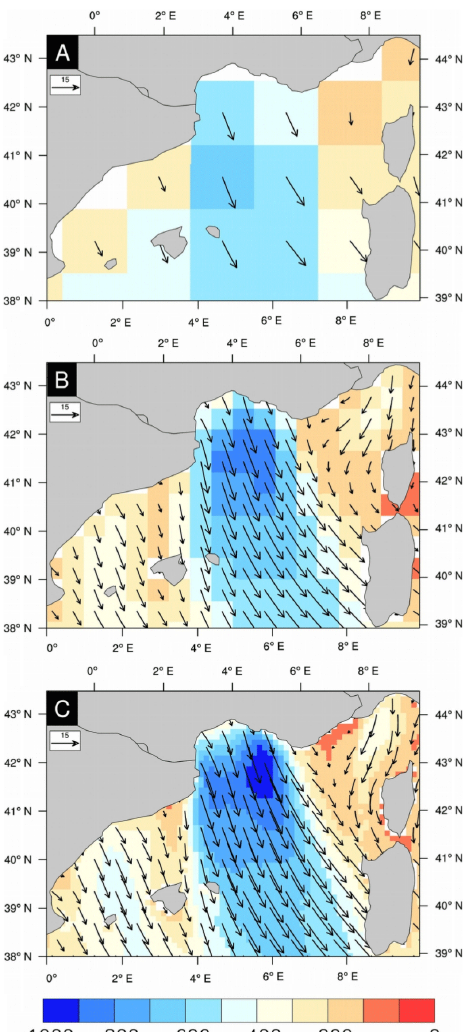
Figure 1. Daily average wind direction (arrows) and latent heat flux (color in Wm − 2 ) on 14 March 2013 in (a) ALADIN- 150km, (b) ALADIN-50km and (c) ALADIN-12km (the so-called ALDERA).